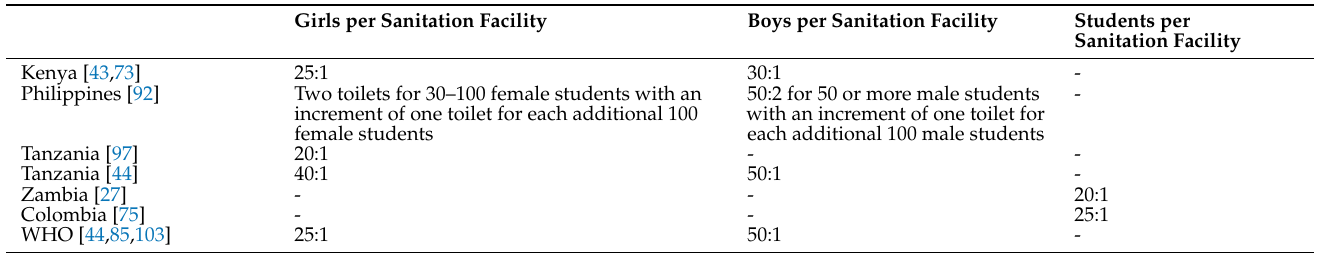
Figure 5. Distribution of students (boy and girls), boy and girl per sanitation facility ratios in schools based on a review of the literature (n = 65 publications). * Reference lines: WHO guidelines of one facility per 25 girls and per 50 boys. Table 5. National requirements of students per sanitation facilities found across studies based on a review of the literature (n = 65 publications).